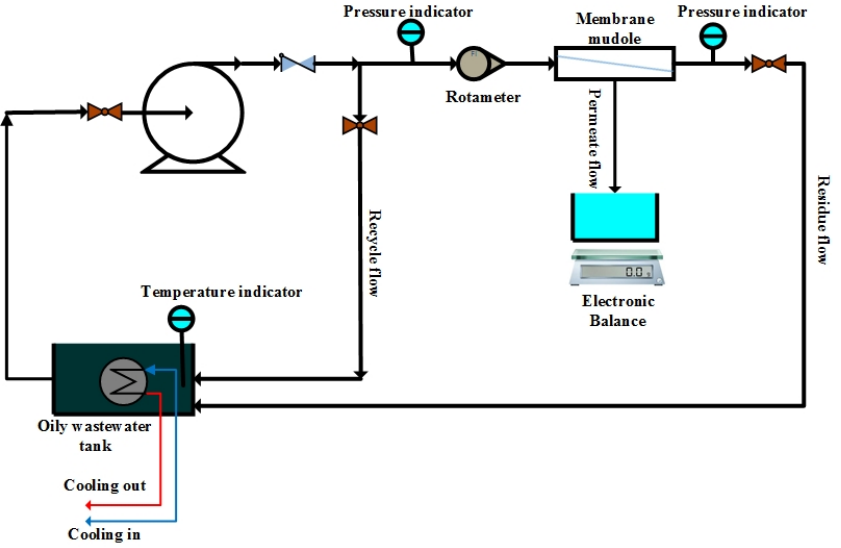
Figure 4. Experimental setup used for investigation of ceramic membrane performance during desalter wastewater treatment.